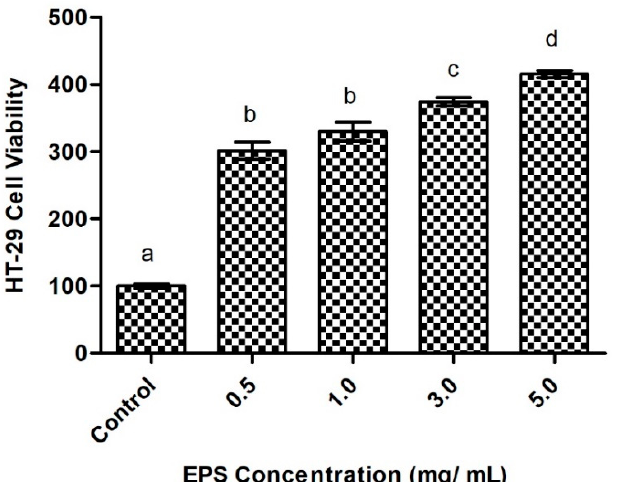
Figure 5. The effect of Apilactobacillus waqarii EPS on HT-29 intestinal cell viability at various concentrations. The values of data sets ( n = 5) denoted by different alphabet are significantly different ( p < 0.05).